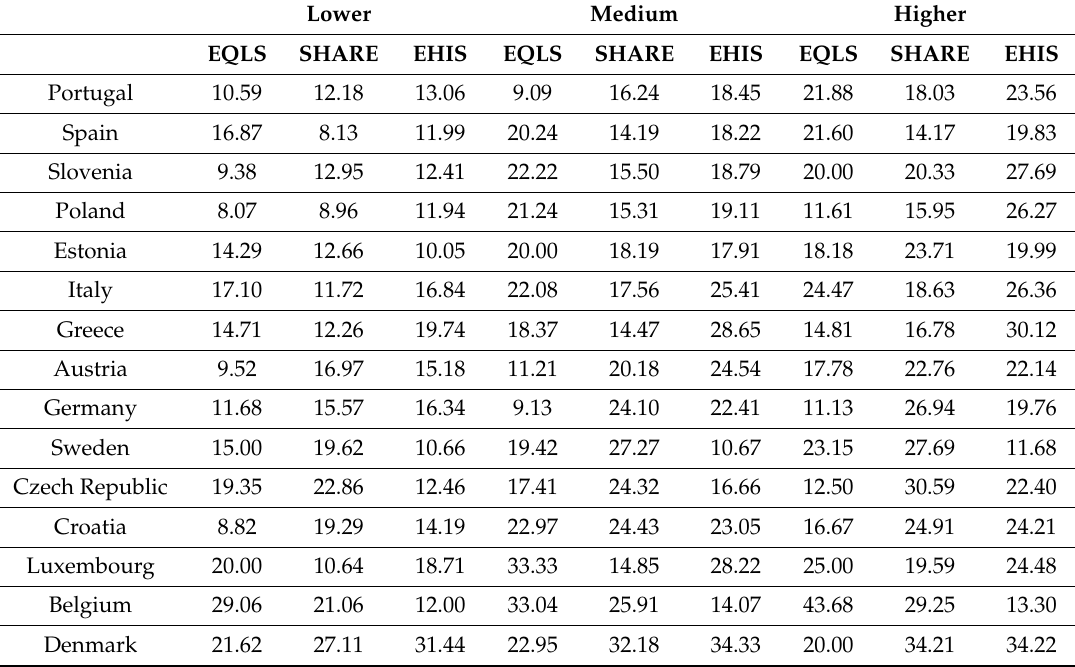
Table 5. Informal Caregivers over 50, by education level